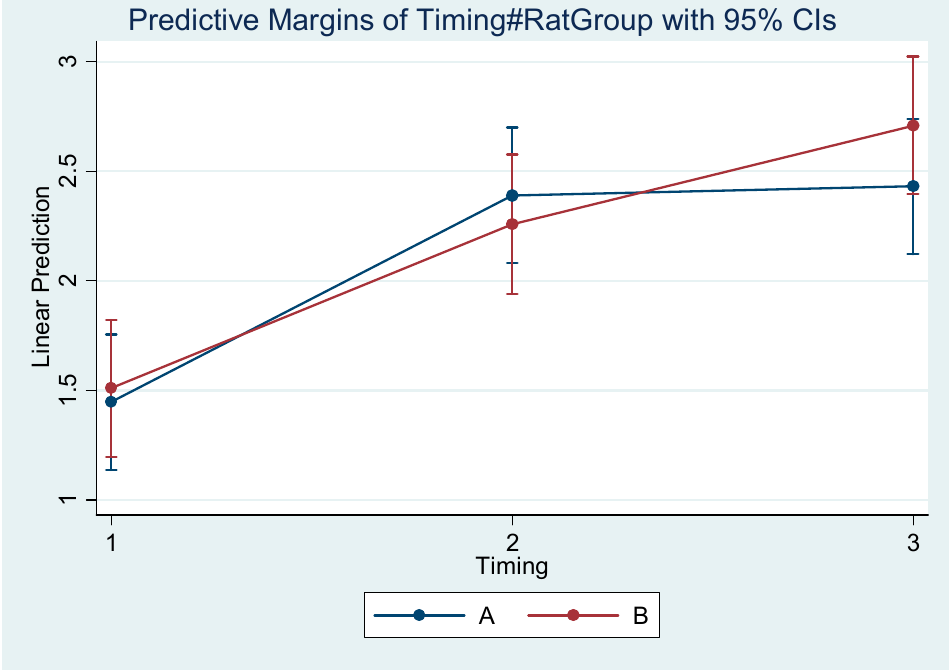
Figure 7. Estimated mean difference (Final–Initial) and 95% Confidence Interval per group and timing in Condylion/Go’–Menton (Condylion height).